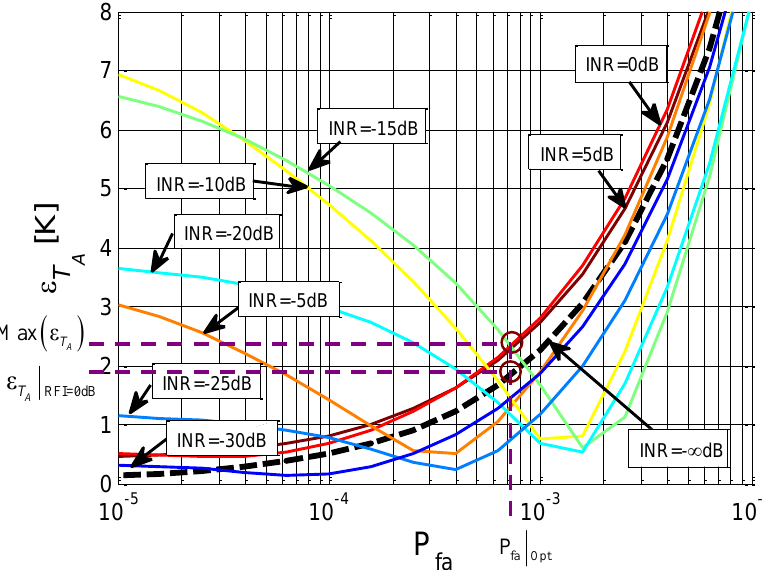
Figure 8. Error obtained by the Smoothing Algorithm in the retrieved T Hann window as smoothing filter. Error is represented in Kelvin ( y -axis), threshold value in P ( x -axis). Colored lines represent RFI contaminated radiometric signals with INR fa value determined by its label. Black dotted line represents a radiometric signal in abscense of